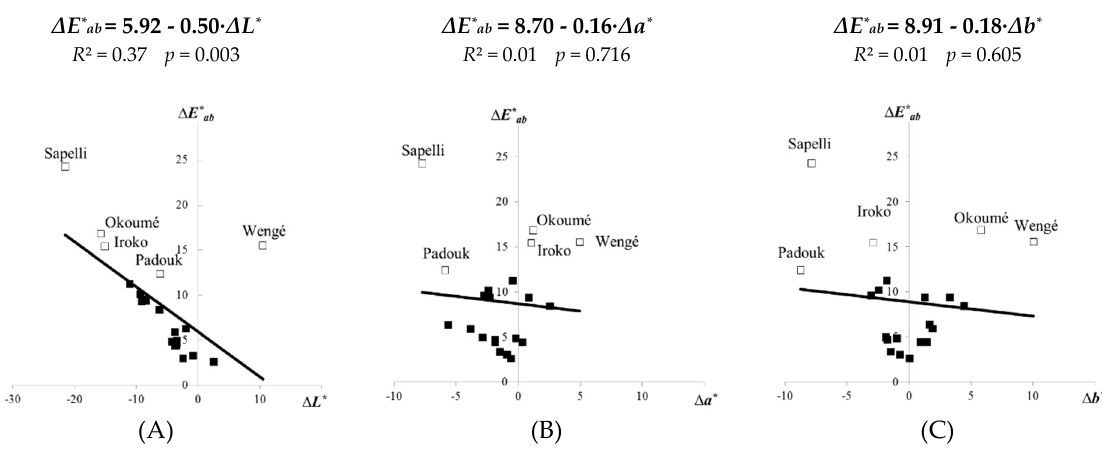
Figure 5. Linear correlations between the total colour difference ∆ E ∗ ab and changes of other colour parameter ∆ L * ( A ), ∆ a * ( B ), ∆ b * ( C )—for 21 tropical woods attacked with the brown-rot fungus C. puteana.